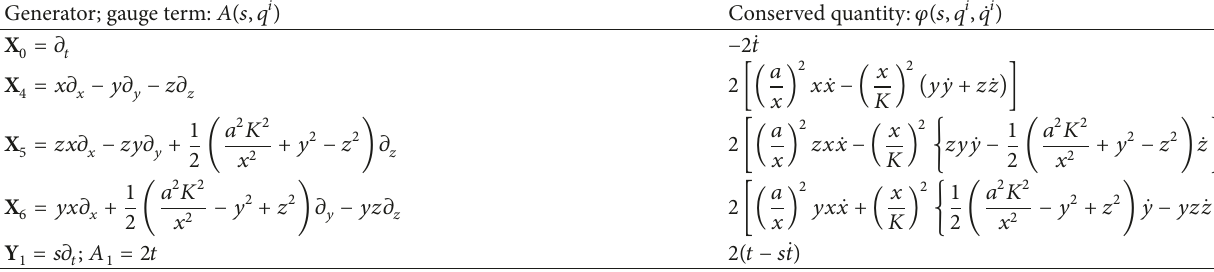
Table 14: Conserved quantities corresponding to each Noether